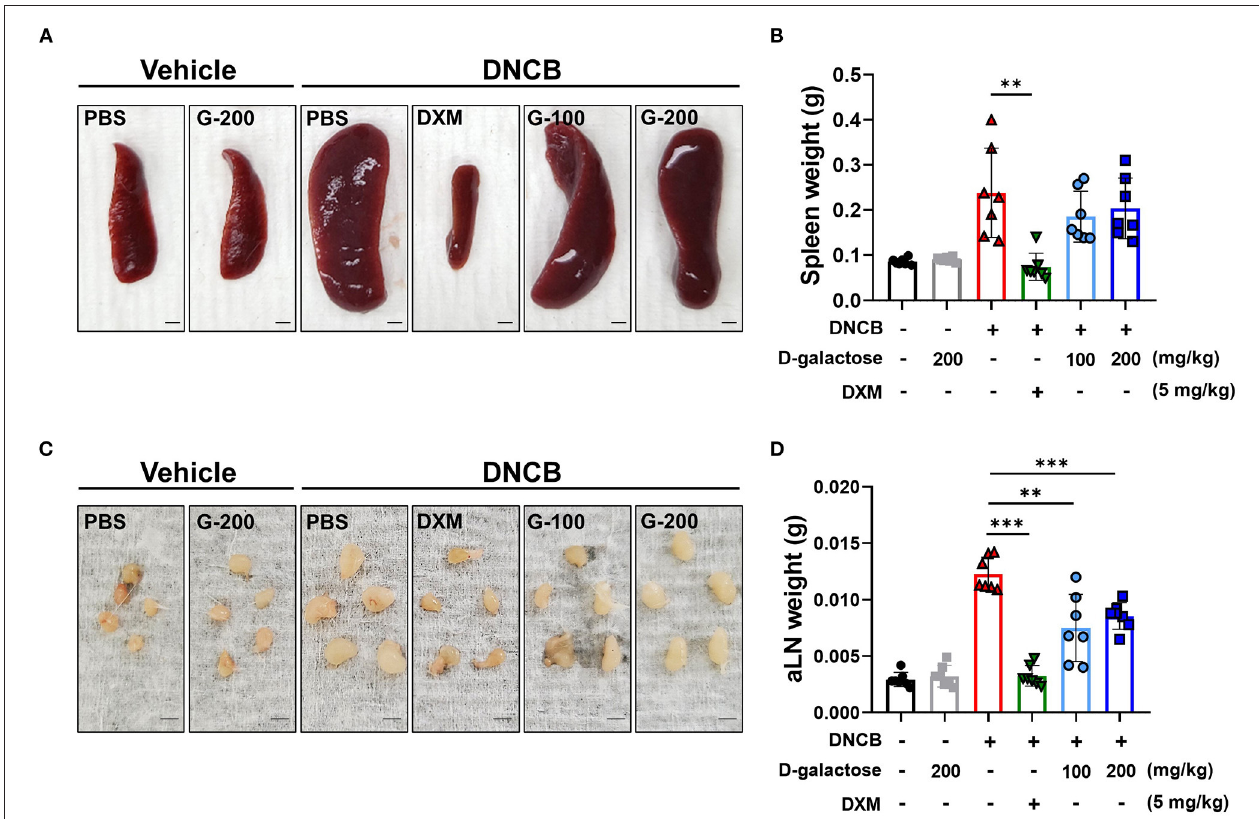
FIGURE 2 | Effects of D-galactose on spleen and axillary lymph nodes of mice with DNCB-induced atopic dermatitis. Size comparison of (A) spleen and (C) axillary lymph node with or without D-galactose treatment (Scale bars, 1mm). Comparison of (B) spleen weight and (D) axillary lymph node weight. Values are means ± SD. Significant differences between the data were assessed using Mann-Whitney U -test, with the level of significance set at * P < 0.05, ** P < 0.01, *** P <